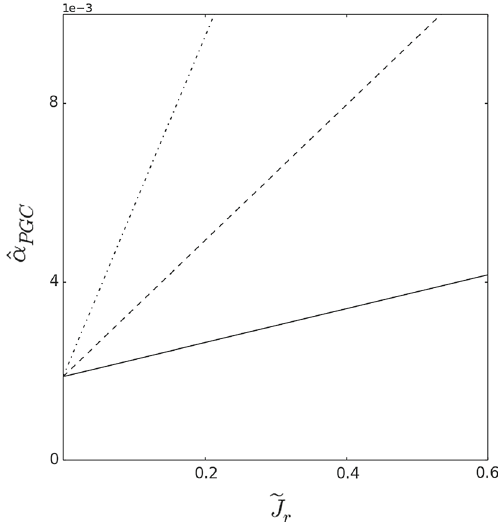
Fig. 13 Plot of ˆ α PGC vs. (cid:22) J r for Λ = 1 (continuous line), Λ = 0 . 25 (dashed line), and Λ = 0 . 1 (dot-dashed line). We used r 0 = 1 . 2, sin χ = 1, s = 0 . 03, b = 100 and ω 2 for the deflection angle: each value is multiplied by 1 e − 3 = 1 × 10 − 3